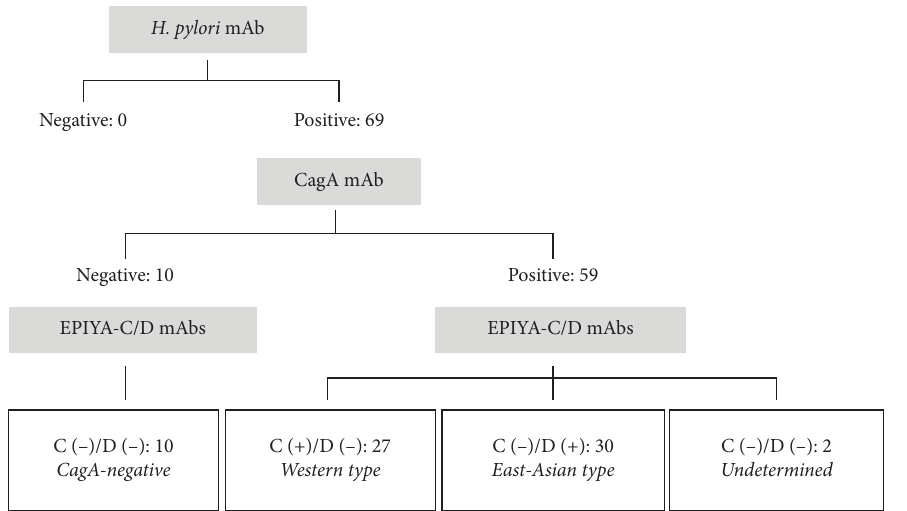
Figure 2: Algorithm for H. pylori CagA typing by IHC using gastric biopsy samples. Te number of samples with positive or negative results by IHC with each of the H . pylori mAb (specifc to species-specifc LPS), the CagA mAb (specifc to a common CagA motif), and the EPIYA- C/D mAbs (specifc to either an EPIYA-C or EPIYA-D motif) are shown in the algorithm for CagA status determination. Te detection status was positive (+) or negative ( − ) by IHC with the EPIYA-C mAb (C) or the EPIYA-D mAb (D). According to the algorithm, the CagA status of the 69 H. pylori -infected patients was determined as either the Western type, East Asian type, or CagA-negative H. pylori , excluding 2 patients with undetermined